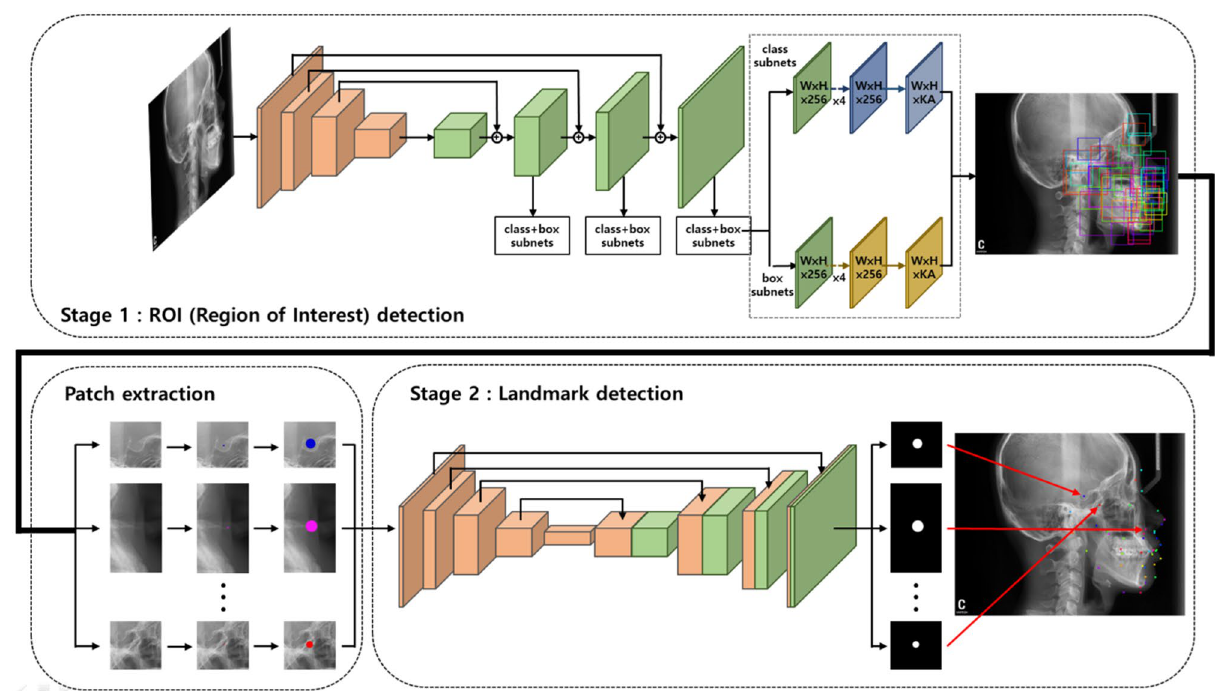
Figure 2. The general schematic of our proposed algorithm for finding the exact location of landmarks with a cascade network. The proposed algorithm consists of two parts, ROI detection (upper part) to propose the area of interest and the landmark prediction (lower part) to find the exact location of landmarks.